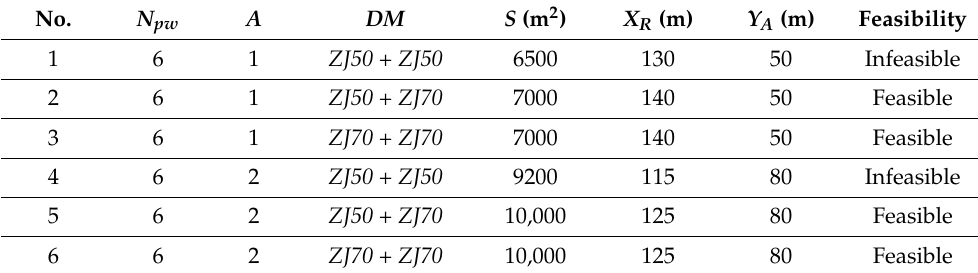
Table 4. Possible wellhead alignment, combined with the rig